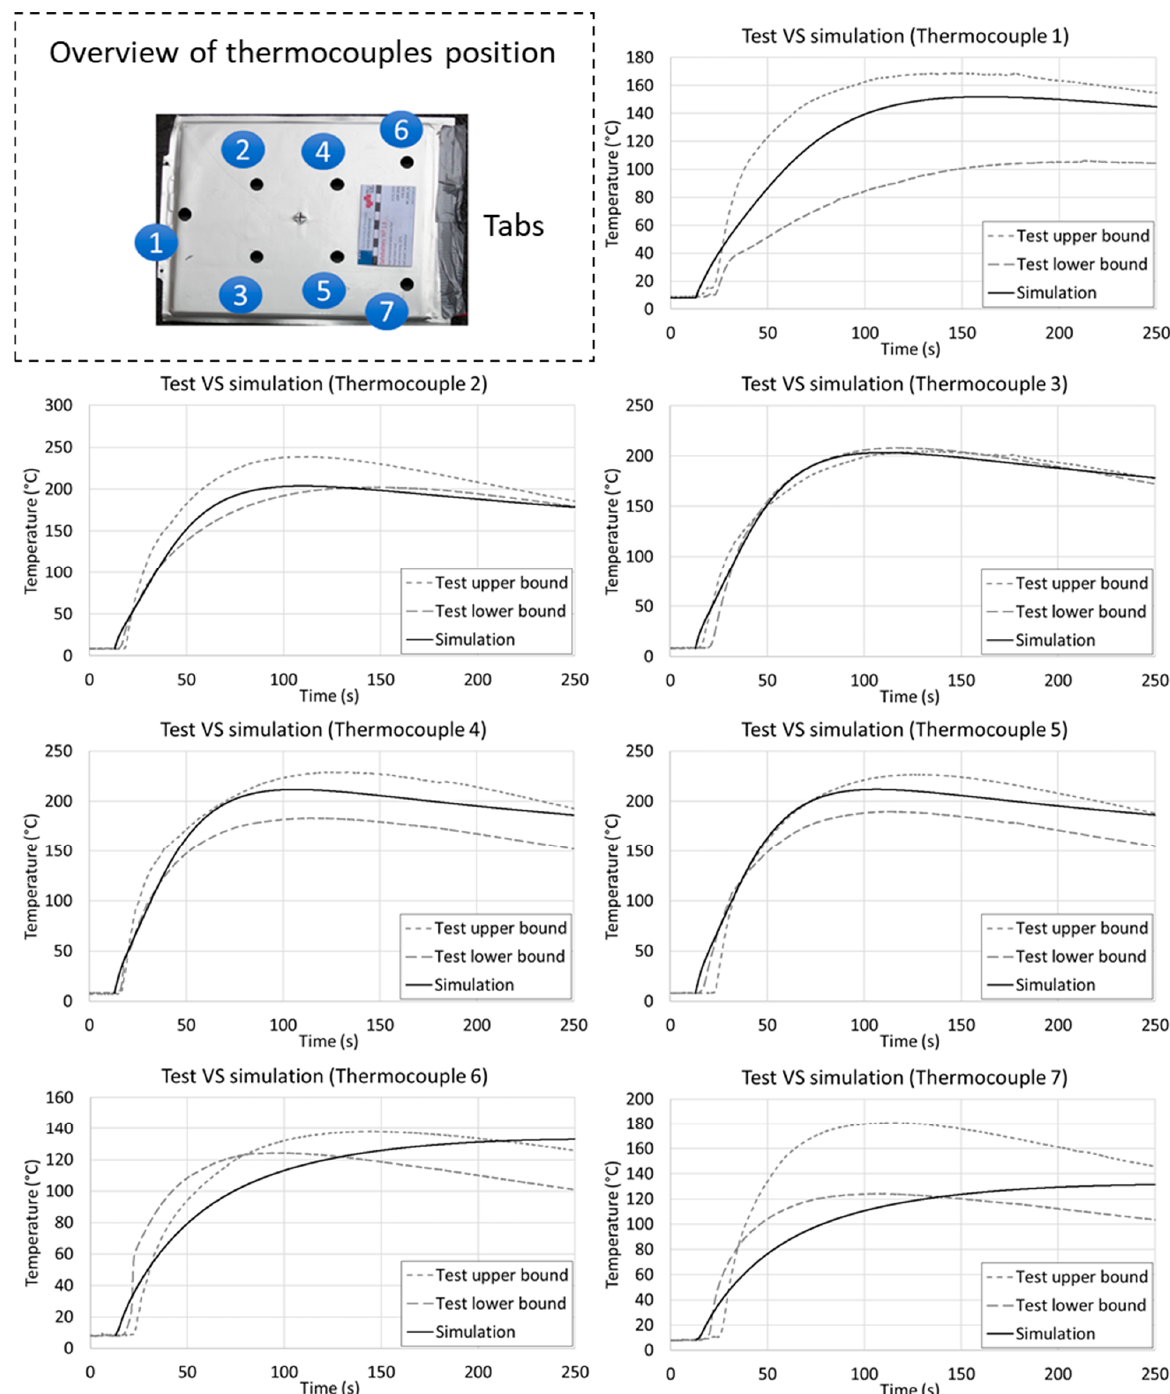
Figure 12. Comparison among the temperatures on the cell surface in the tests and simulation for the nail penetration load case. The simulation monitor points were chosen with respect to the thermocouples in the experiments. With the exceptions of thermocouples 6 and 7, all other temperature results are consistent in terms of the maximum temperature and transient behavior.